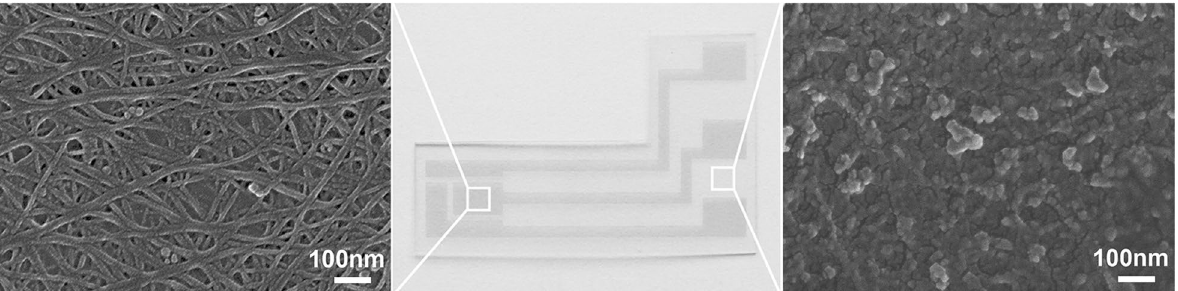
Fig. 2 Optical and SEM images of three SWCNT electrode‑based biosensor patterned by O 2 plasma treatment. The left and right SEM images were obtained from patterned (gray) and etched (transparent) SWCNT areas on a PET substrate